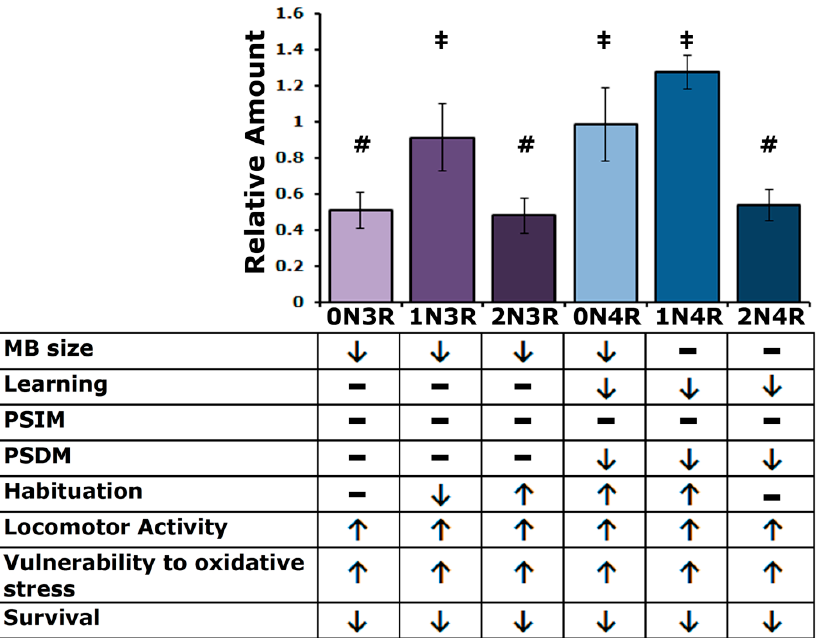
Figure 9. A summary of hTau steady state levels and isoform specific phenotypes as detailed in the text. Bars marked with # are not significantly different from each other but are from those marked with ‡ and conversely ‡ marked bars are not significantly different from each other but are from ones marked with #. Arrows denote changes in phenotype (up or down) compared to controls, while dashes denote no effect.